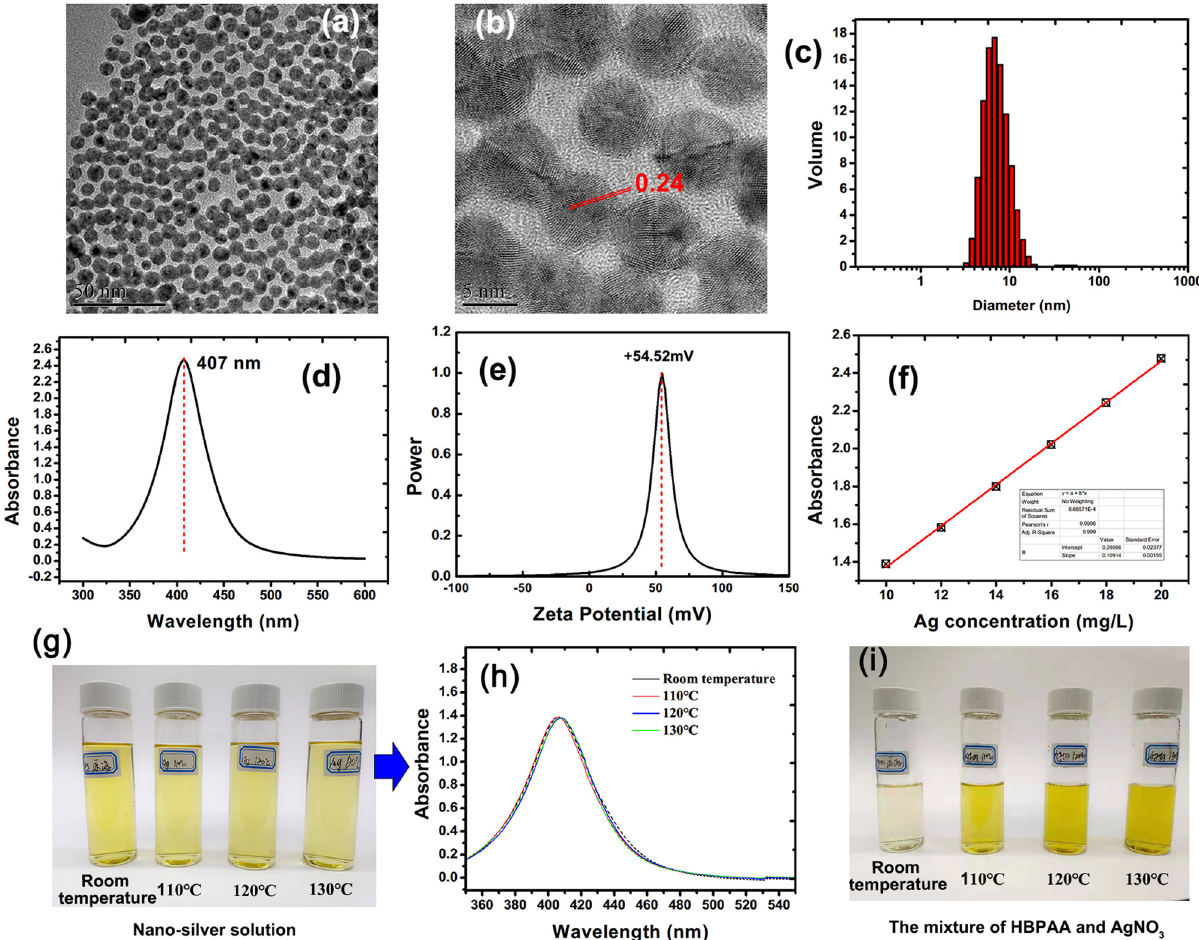
Figure 1: ( a and b ) TEM images, ( c ) particle size distribution, ( d ) UV - vis spectra, and ( e ) zeta potential of AgNPs. ( f ) Linear fi tting curve of Ag concentration and the corresponding UV - vis absorbance ( 407 nm ) . ( g ) Photos and ( h ) UV - vis spectra of nano - Ag solution ( 10 mg/L ) after treatment at di ff erent temperatures for 2 h. ( i ) Photos of the mixture of AgNO 3 and HBPAA after treatment at di ff erent temperatures for 2 h. The corresponding Ag content was 10 mg/L, and the mass ratio of Ag to HBPAA was the same as the as - prepared nano - Ag